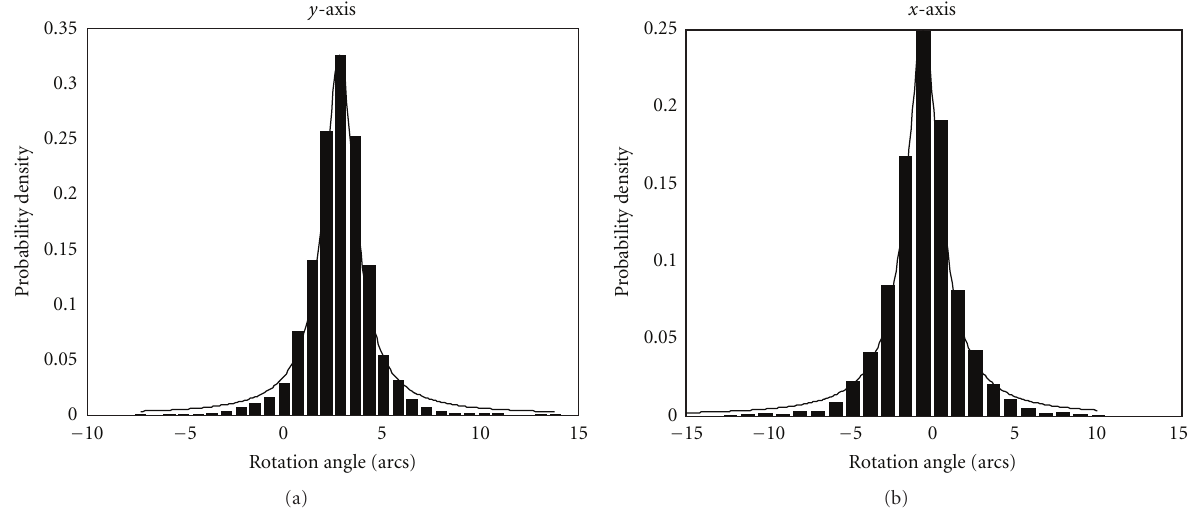
Figure 6: The angle of wave tilt (wave rotation) determined for x and y axes by analyzing the vortex triplets geometry. The expected values were 2.5 second of arc through y -axis and 0 second of arc through x -axes. In this example, around 350 vortices were observed at the image area. The statistics were made for 3500 triplets. Probability density function can be described by the Lorentz distribution (when using cells instead of triplets, we get the Gaussian distribution).